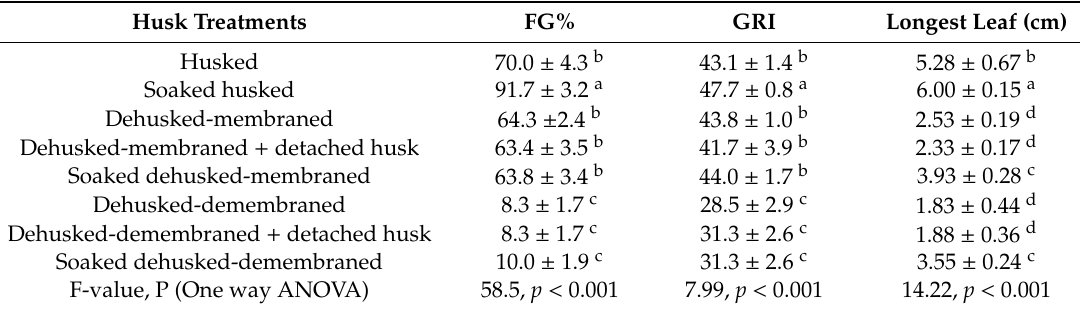
Table 1. E ff ect of husk treatments on final germination in light (FG), germination rate index (GRI) and longest leaves (mean ± SE) of Brachypodium hybridum grains and seedlings. Means of di ff erent husk treatments having the same letters within each variable are not significantly di ff erent at p ≤